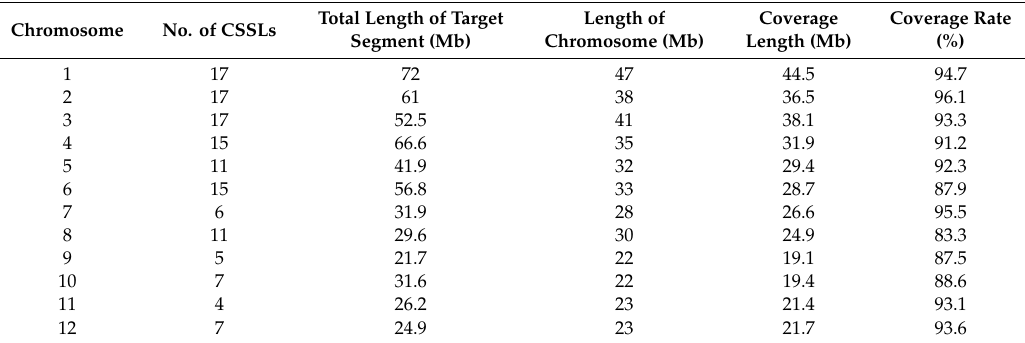
Table 2. Substitution segment analysis in DP30-CSSL.